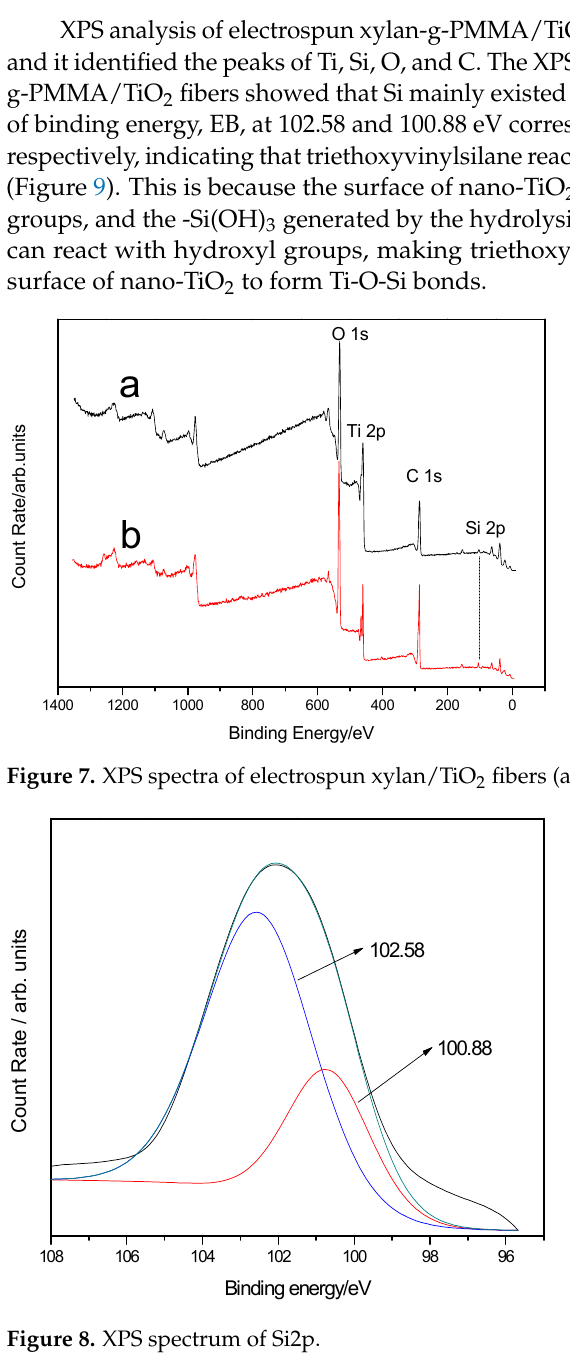
Figure 8. XPS spectrum of Si2p.